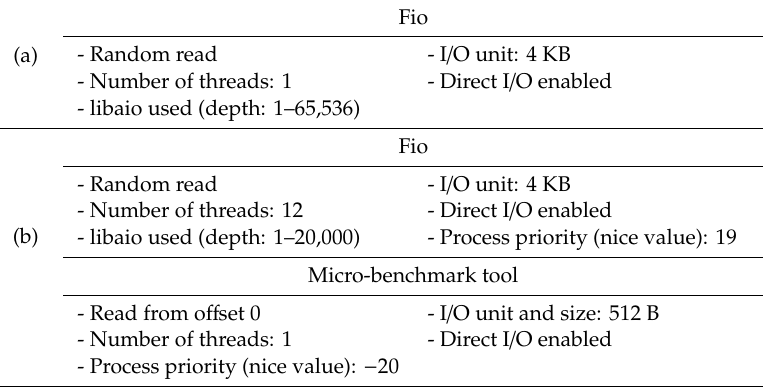
Table 3. Configuration for generating I / O workloads to (a) count the number of I / O requests enqueued in the submission queue and (b) measure I / O delays caused by pending I / O requests in the submission